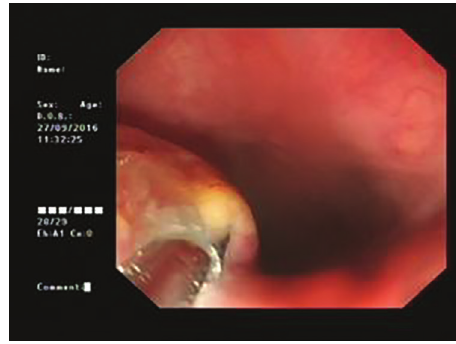
Figure 4. MR reexamination result of the thoracic vertebra after the